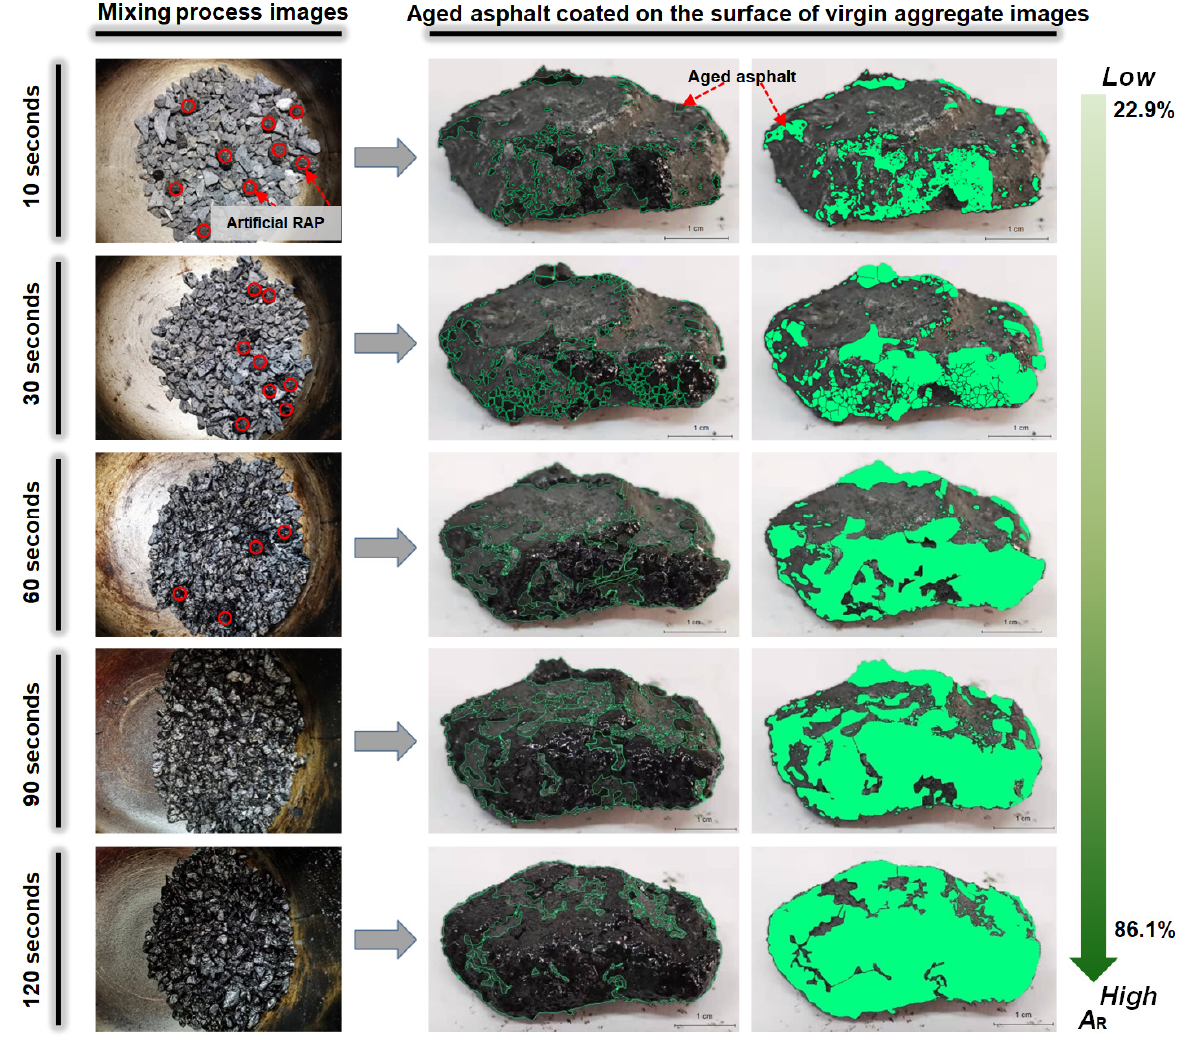
Figure 6. Dispersion of aged asphalt over the virgin aggregate surface with different mixing dura- tions.